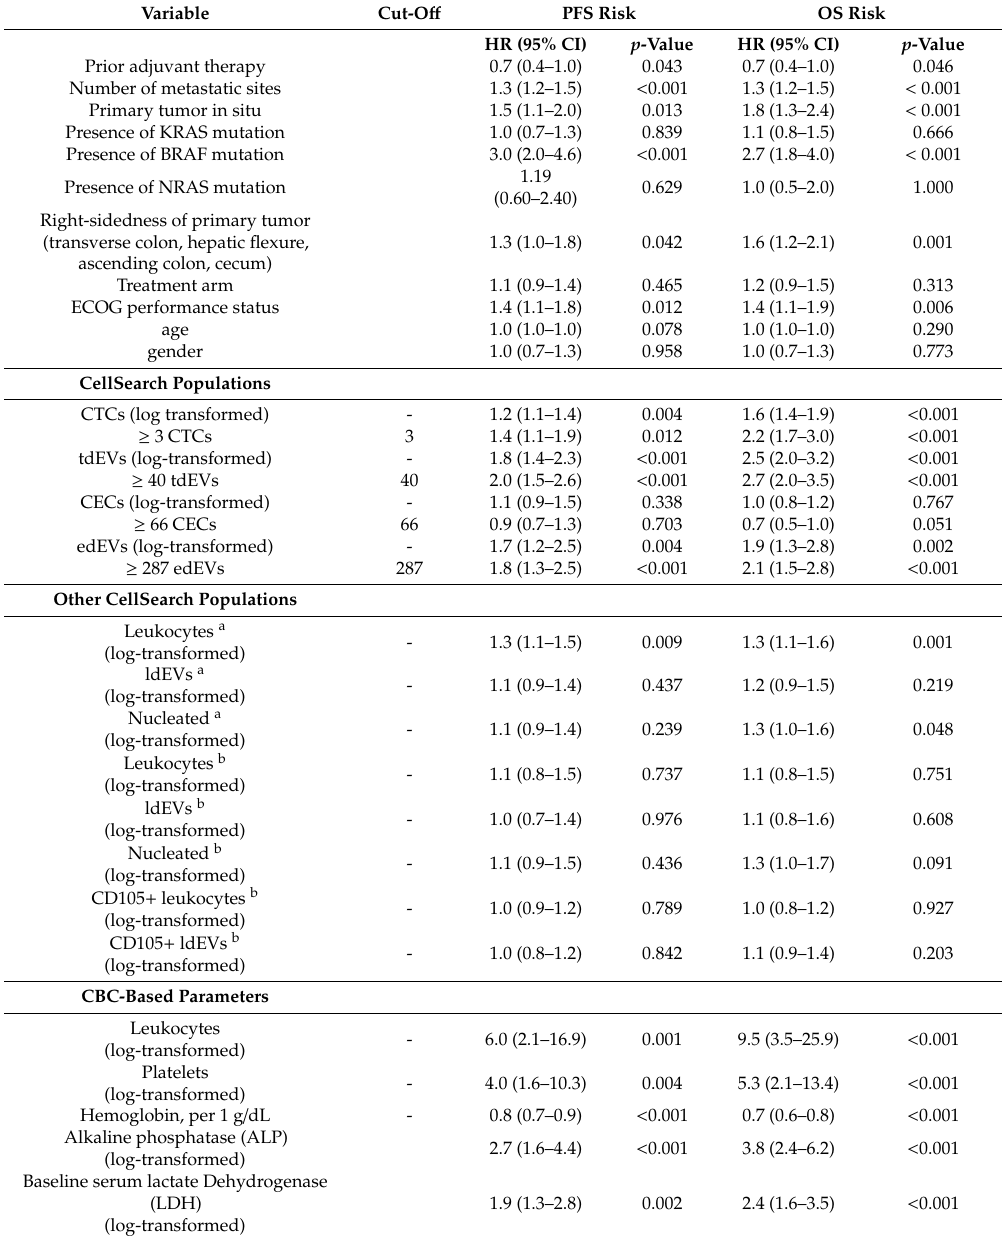
Table 1. Univariable Cox proportional hazards regression